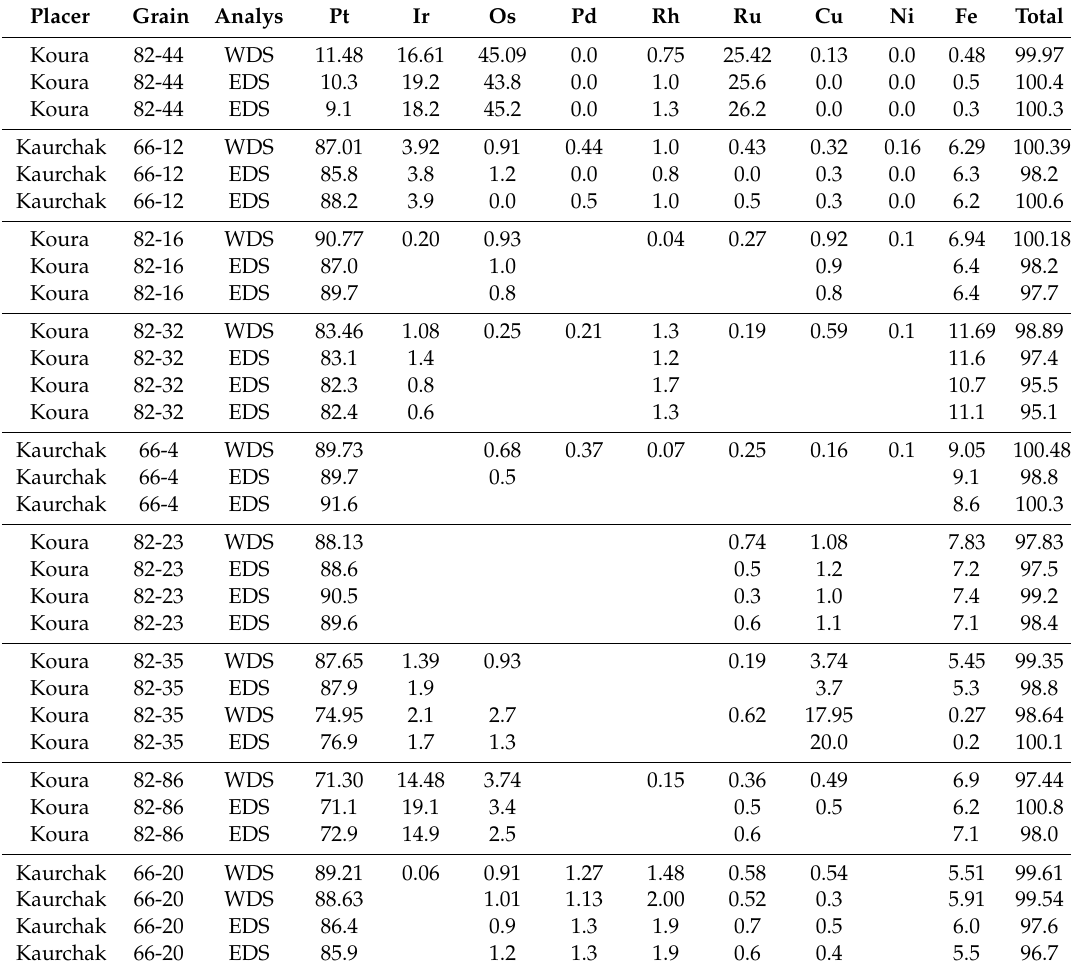
Table 1. Comparison of sample results of WDS (microprobe) and EDS (SEM) of PGM analyzes of rivers Koura and Kaurchak (Gornaya Shoria, southern Siberia, Russia)